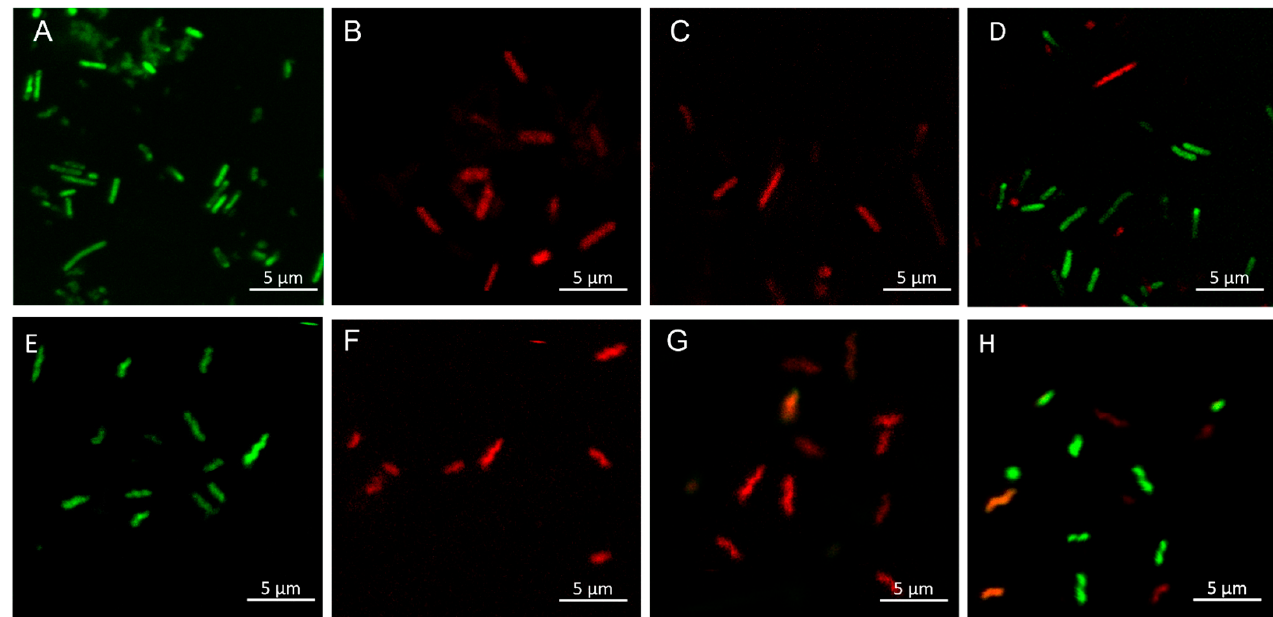
Figure 5. Permeability of the L. monocytogenes ( A – D ) and C. jejuni ( E – H ) cell membranes after treatment with chitosan films. ( A )—control, ( B )—CS ‐ ZnO 2:1a, ( C )—CS ‐ GO ‐ Ag, ( D )—CS ‐ Ag ( E )—control, ( F )—CS ‐ ZnO 2:1a, ( G )—CS ‐ GO ‐ Ag, ( H )—CS ‐ Ag.